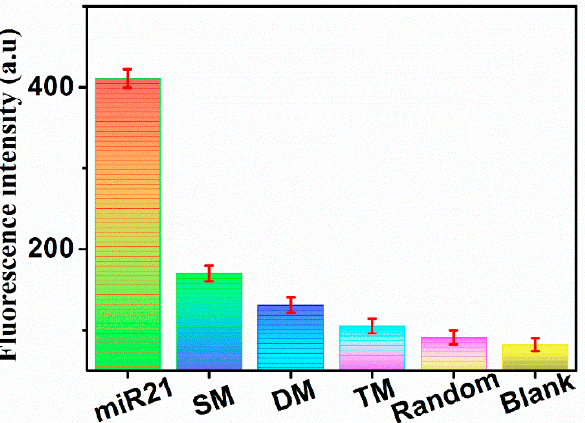
Figure 6. Fluorescence intensity of the fluorescent biosensor in the presence of exosomal miR-21 (1 pM), SM (single-base mismatch, 10 pM), DM (double-base mismatch, 10 pM), TM (triple-base mismatch, 10 pM), random (10 pM), and blank, respectively. (Error bars: SD, n = 3).